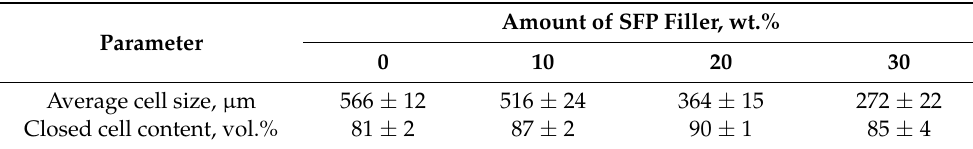
Table 3. Structural parameters of SFP filler-modified PUR